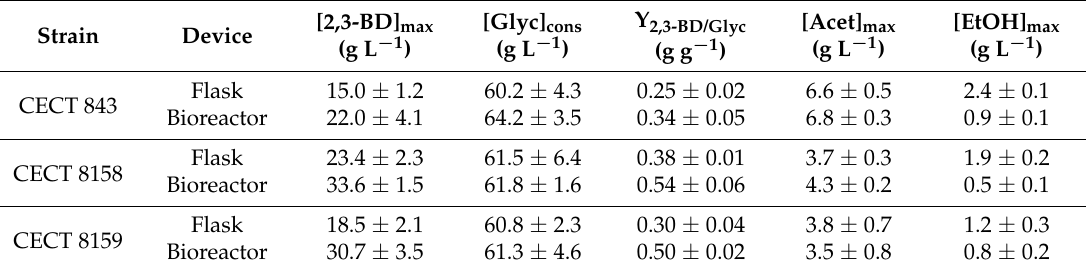
Table 2. Flask and bioreactor fermentation results of R. planticola CECT 843 and mutants CECT 8158 (IA1) and CECT 8159 (IIIA3) with MC culture medium and the optimal conditions